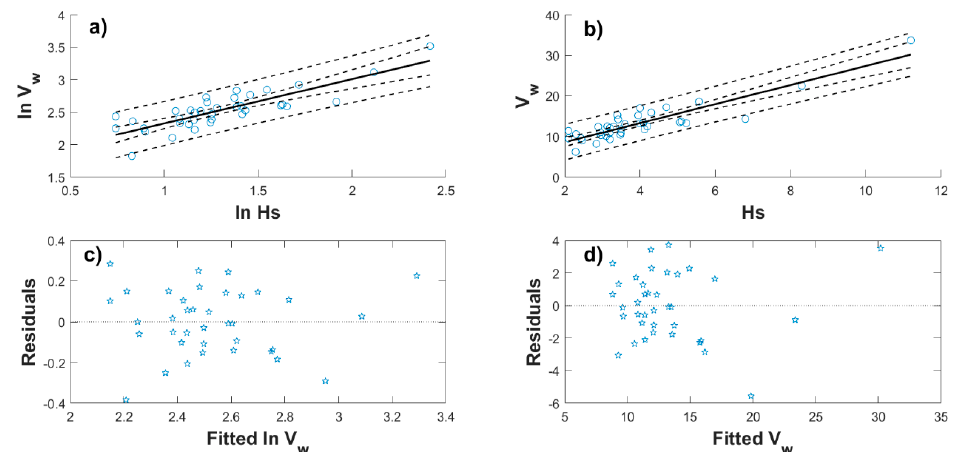
Figure 3. Regression and residual analysis by using ( a ) nonlinear (Equation (9)) and ( b ) linear (Equation (7)) models for October. Residuals using ( c ) Equation (9) and ( d ) Equation (7).